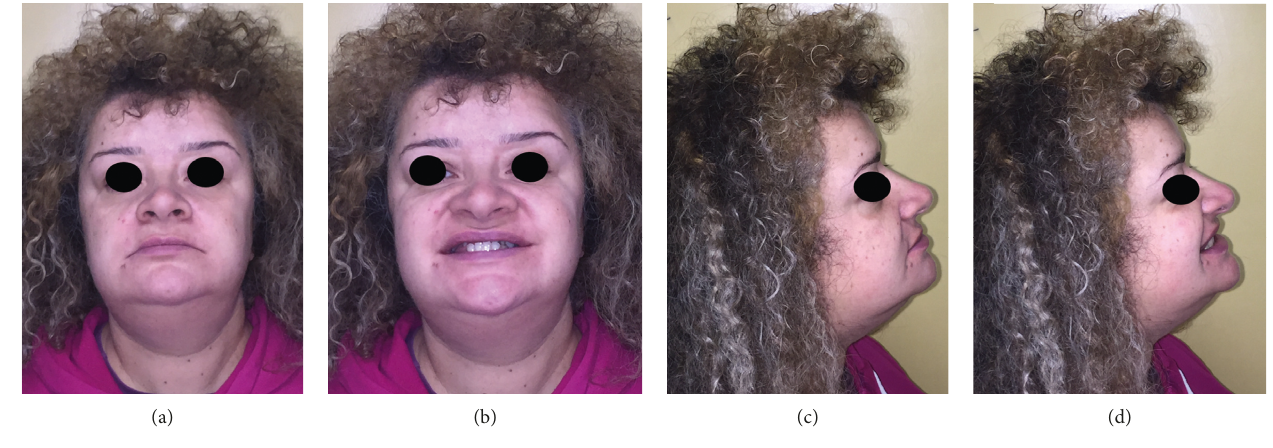
Figure 16: Case 3: extraoral